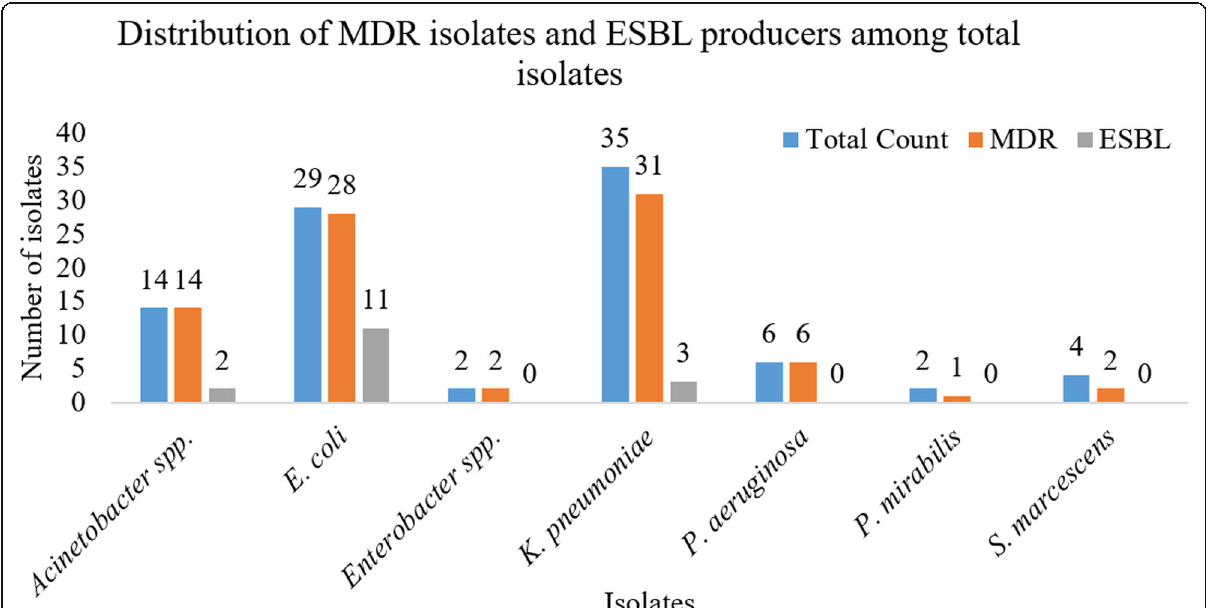
Fig. 2 Distribution of MDR isolates and ESBL producers among total isolates